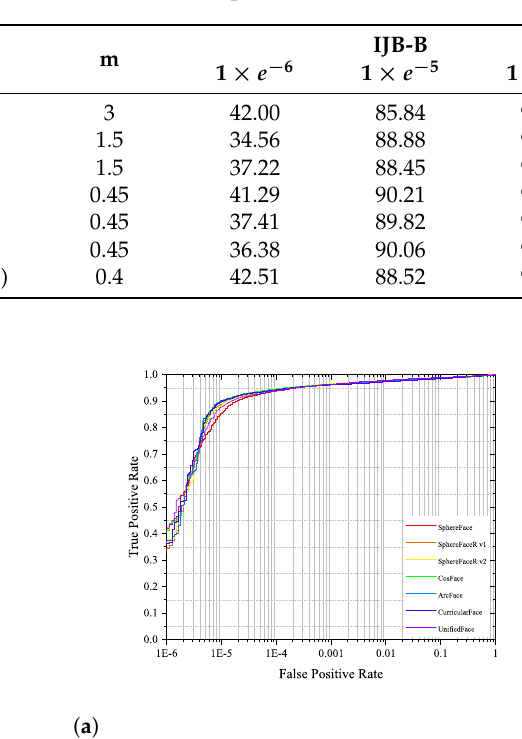
Table 11. Evaluation on IJB-B and IJB-C. We use ResNet-100 as the backbone architecture and MS1MV3 as the training dataset for all the compared methods. Results are in % and higher number indicates better performance.